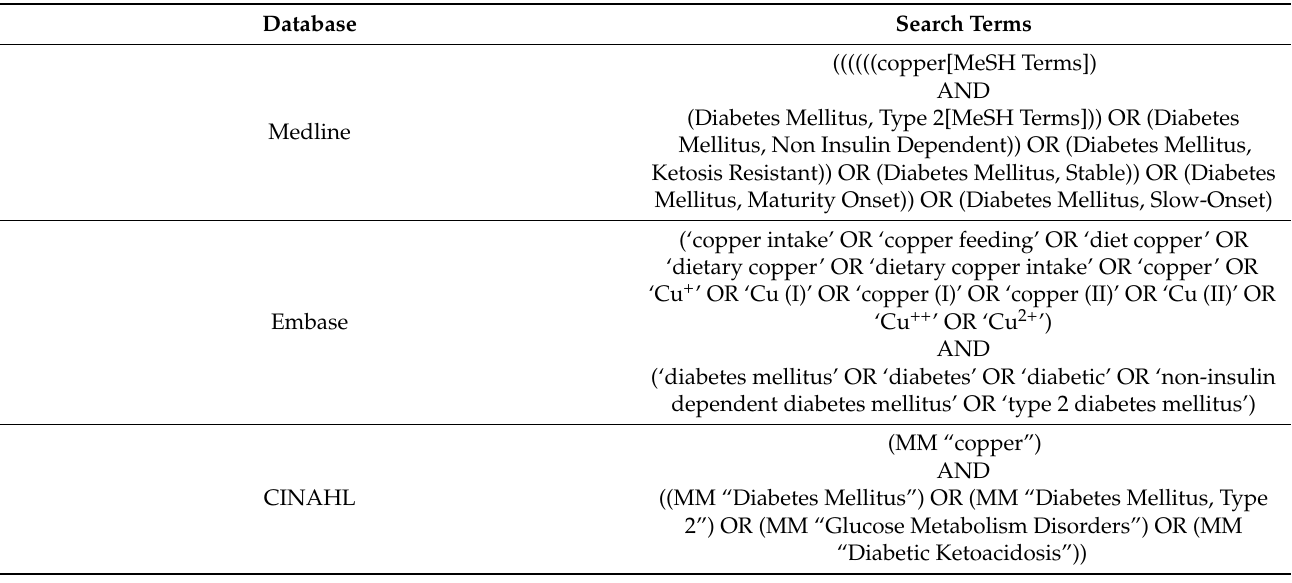
Table 1. Search Terms used in Medline, Embase, and